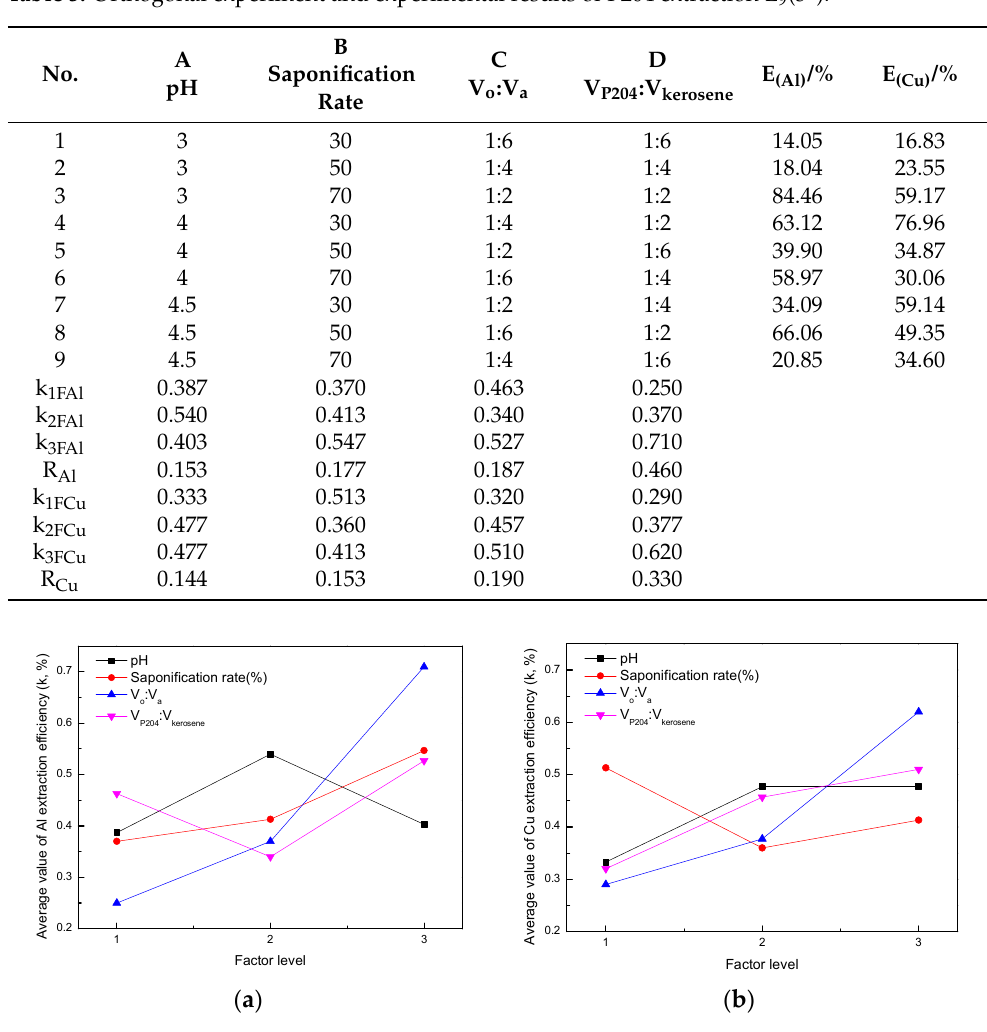
Table 3. Orthogonal experiment and experimental results of P204 extraction L 9 (3 4 ).